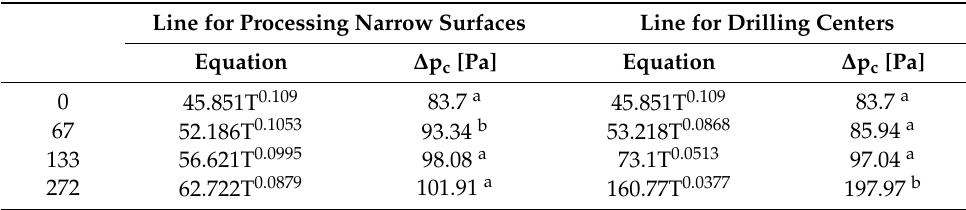
Table 5. Summary of regression equations and pressure drop values for the 50th filter cycle. a, b—the same letters in the lines mean no significant differences at the level of significance